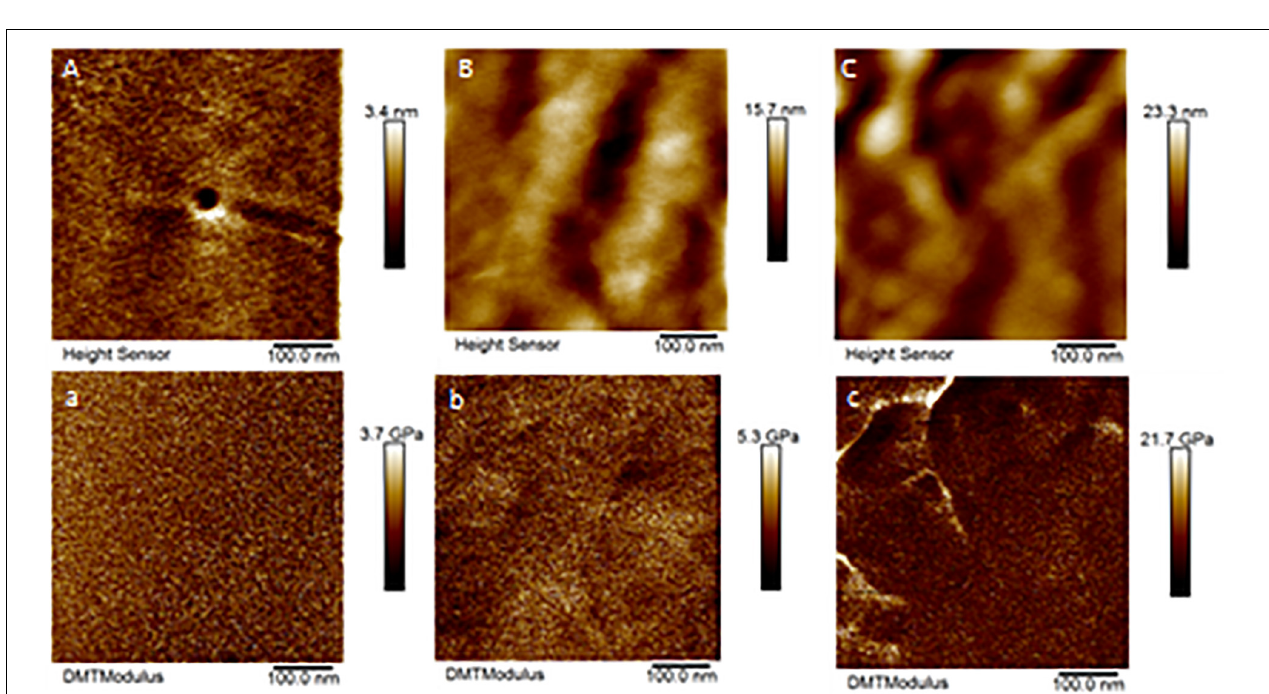
FIGURE 2 | RNA-interference based gene silencing of Aam-40766 (glycine-rich protein gene) in the lone-star tick ( A. americanum ). (A) Transcriptional expression of Aam-40766 and other glycine-rich proteins in the gene silenced partially blood-fed tick tissues. (B) Mass of replete or forcibly removed 12 days fed female ticks. Ubiquitin was used as a housekeeping gene to normalize the transcriptional expression.